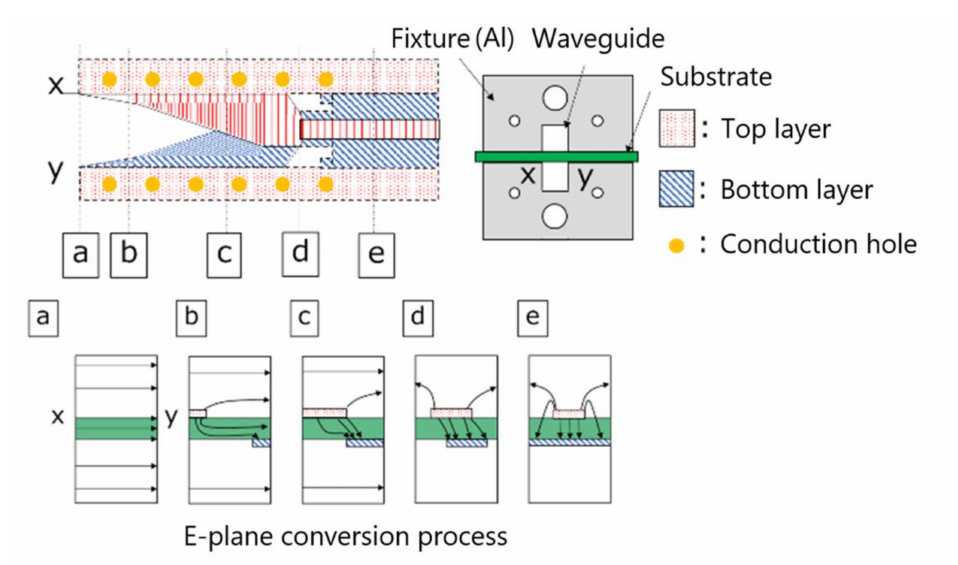
Figure 16. Process of MSL—to—waveguide transmission mode conversion by finline.